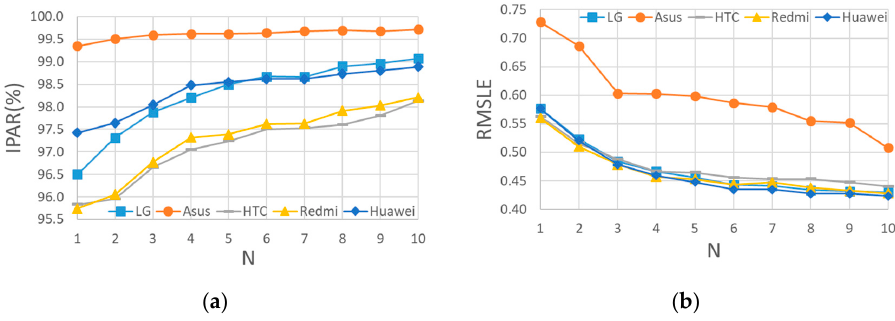
Figure 3. The ( a ) IPAR; and ( b ) RMSLE values of different N seconds for different